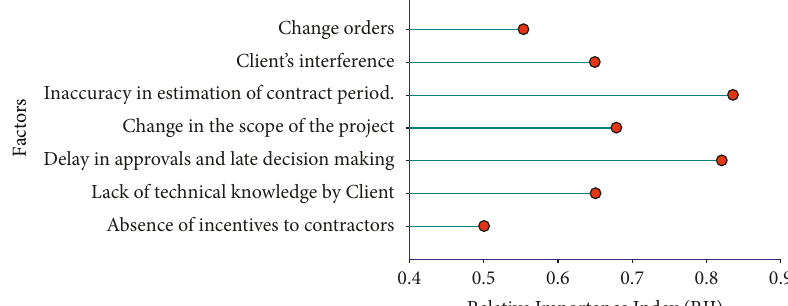
Figure 1: Ranking of client-related factors.